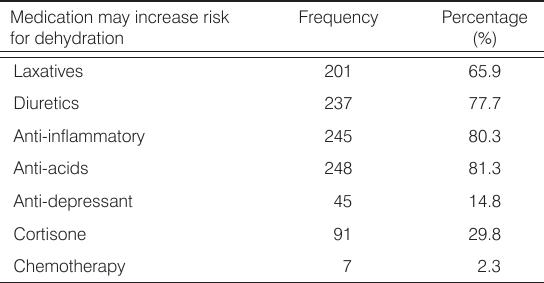
Table 3. The distribution of the medications that increase the risk for dehydration (N = 305).